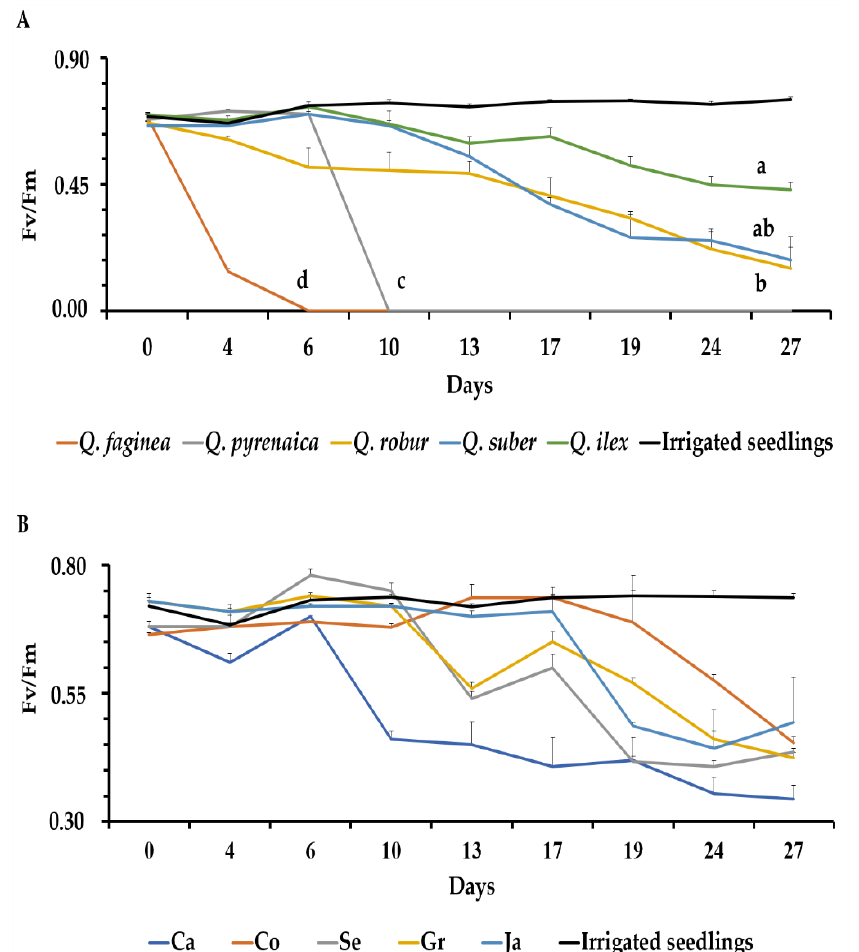
Figure 3. Measurements of quantum yield of photosystem II (F v / F m ) in dark adapted leaves from Quercus spp., ( A ) and Q. ilex interpopulation species ( B ) (non-irrigated seedlings) during drought progression. Values are mean ± SE of three biological replicates. In Quercus spp., the same letter indicates no significant di ff erence between species ( p = 0.05). The black line indicates the mean values of irrigated seedlings shown in Figure S3. The lack of letters in Andalusian Q. ilex populations indicates no significant di ff erences between populations.